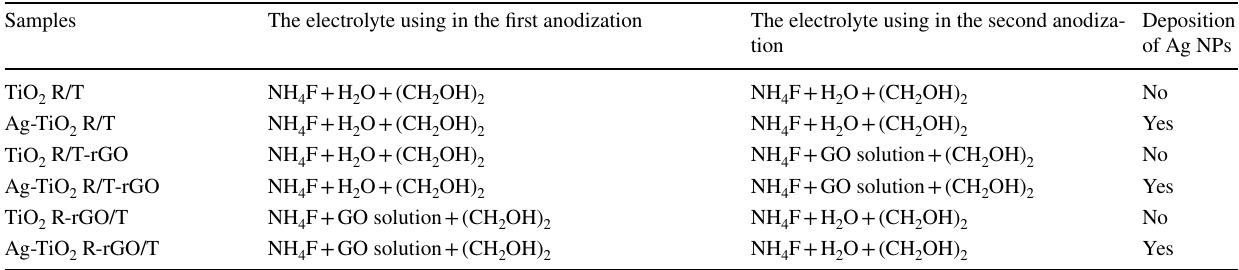
Table 1 Preparation conditions of the TiO 2 -based samples Samples The electrolyte using in the first